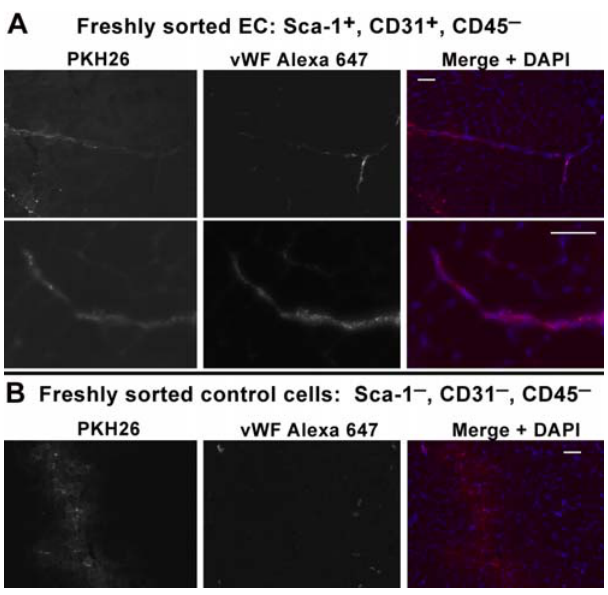
Figure 9. Freshly sorted EC injected intramuscularly also form new vessels and integrate with existing vasculature vs. control cells. A, Tissues sections from mice injected intramuscularly and examined 14 days post injection reveals freshly sorted PKH stained EC also have angiogenic capability. Although freshly sorted EC did not migrate as far as cultured EC several PKH + /vWF + vessels highlighted by anti-vWF staining with Alexa 647 (magenta) were visible beyond the point of injection. B, Contrary to the capability of freshly sorted and cultured EC to form new vessels and integrate with existing ones, control cells sorted as Sca-1 2 , CD31 2 and CD45 2 injected under the same conditions did not exhibit any angiogenic potential. Scale bars=50 m